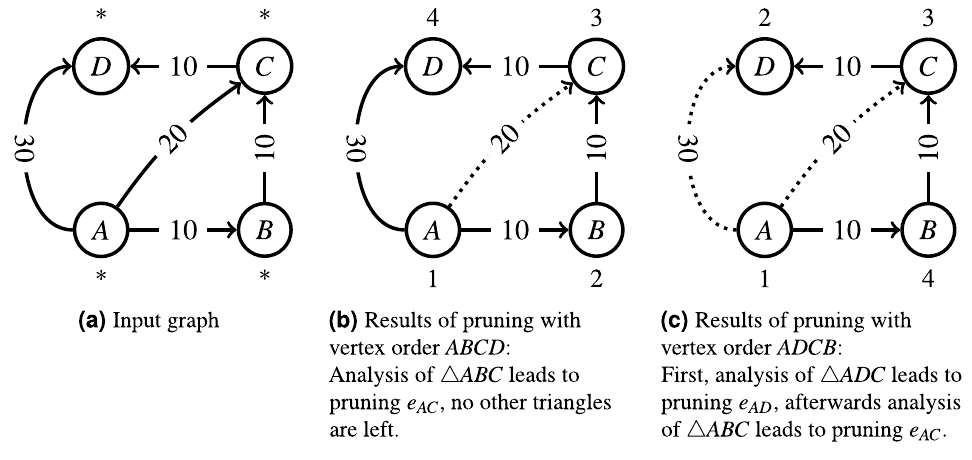
Figure 1. Impact of triplets order on pruning results.